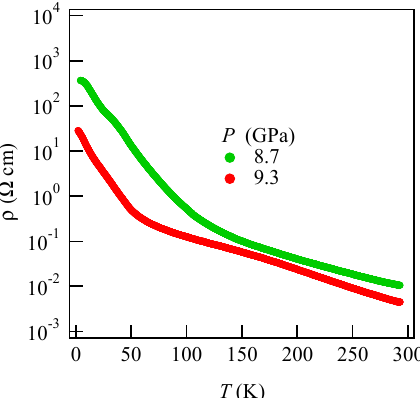
Figure A3. ( a ) Temperature dependence of MR as a function of magnetic field at 10.5 GPa (sample 8). ( b ) Enlarged view of low magnetic field region of MR as a function of magnetic field and temperature at 10.5 GPa.